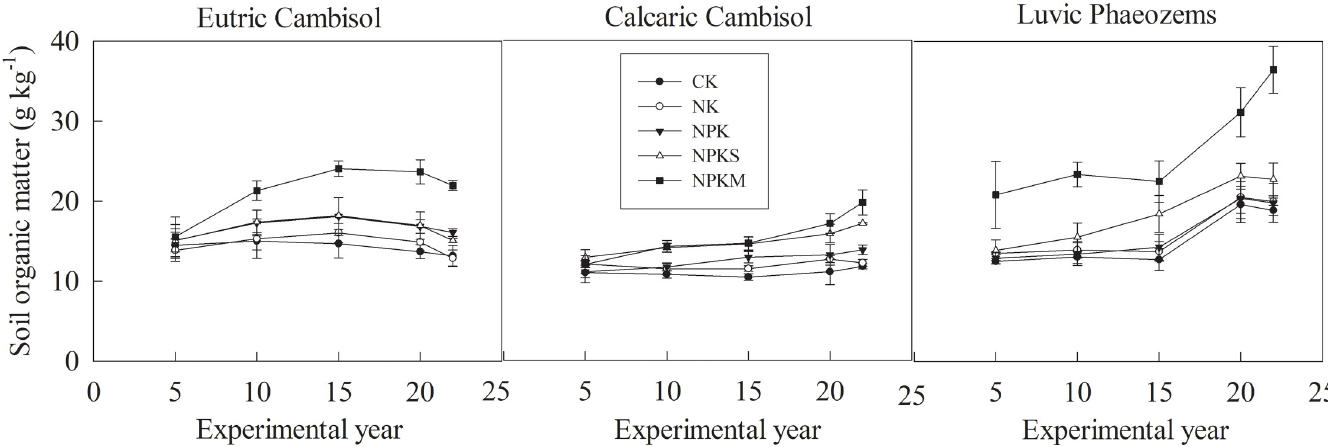
Fig 6. Soil organic matter of the three sites. CK: unfertilized control; NK: nitrogen and potassium; NPK: nitrogen, phosphorous, and potassium; NPKS: nitrogen, phosphorous, potassium and straw; and NPKM: nitrogen, phosphorous, potassium and manure (NPKM).